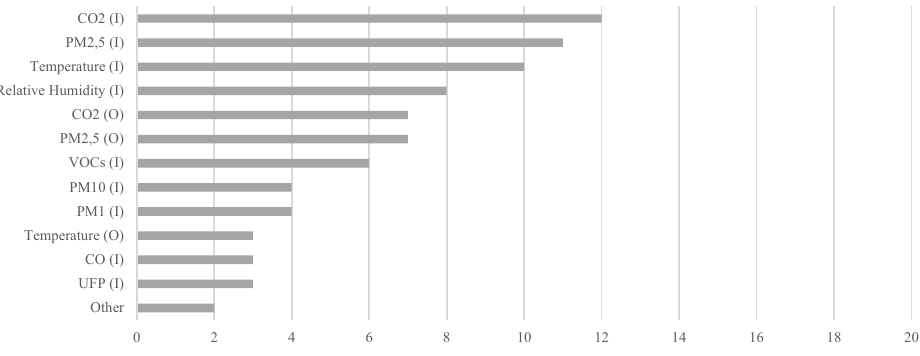
Figure 3. Variables monitored. (I) Indoor; (O)